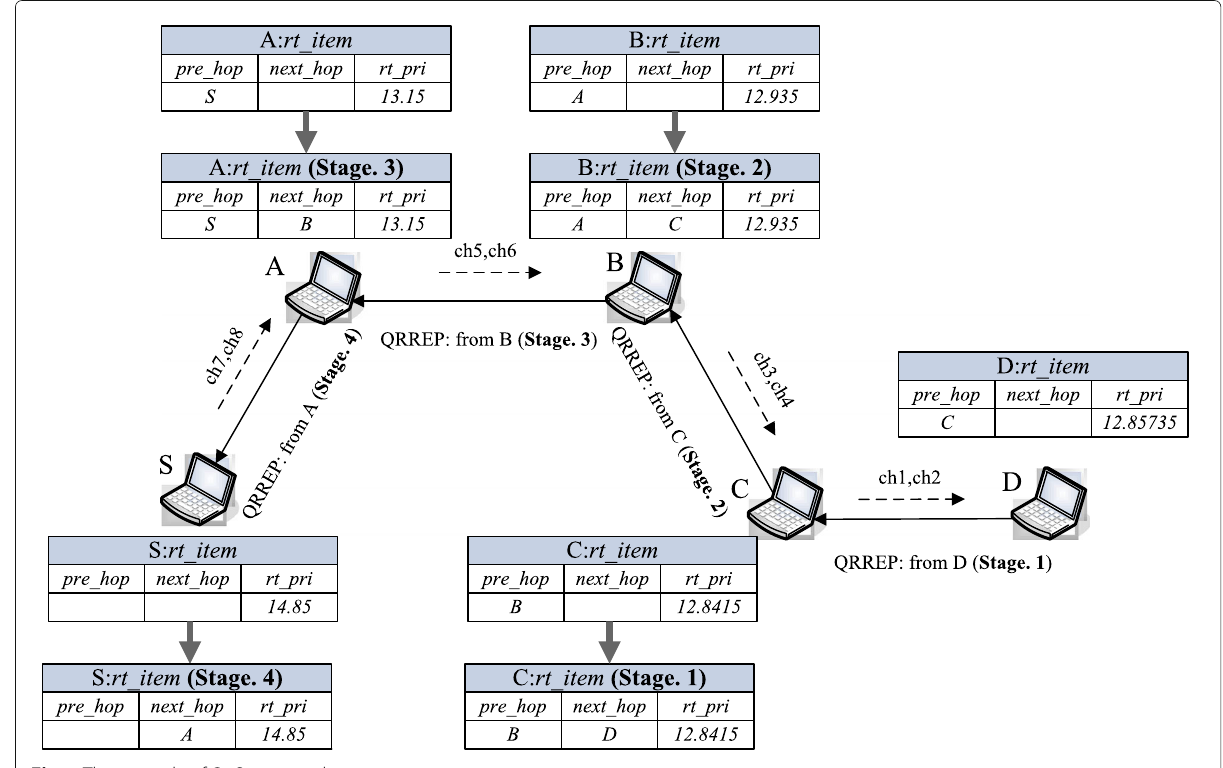
Fig. 4 The example of QoS route reply process